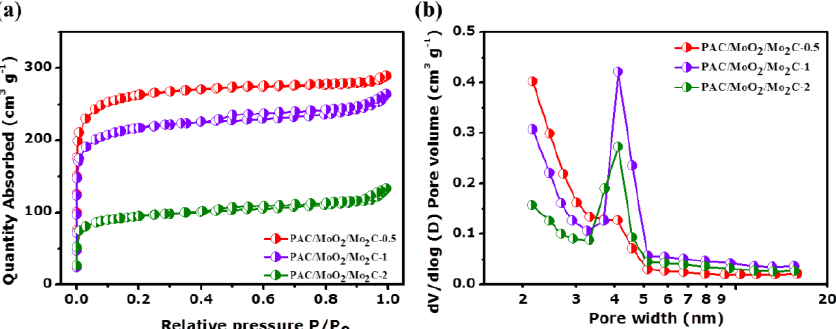
Figure 5. EDX mapping images showing the distribution of C, Mo and O individual elements in: ( a – c ) PAC/MoO 2 /Mo 2 C-0.5, ( d – f ) PAC/MoO 2 /Mo 2 C-1 and ( g – i ) PAC/MoO 2 /Mo 2 C-2 ternary composites.